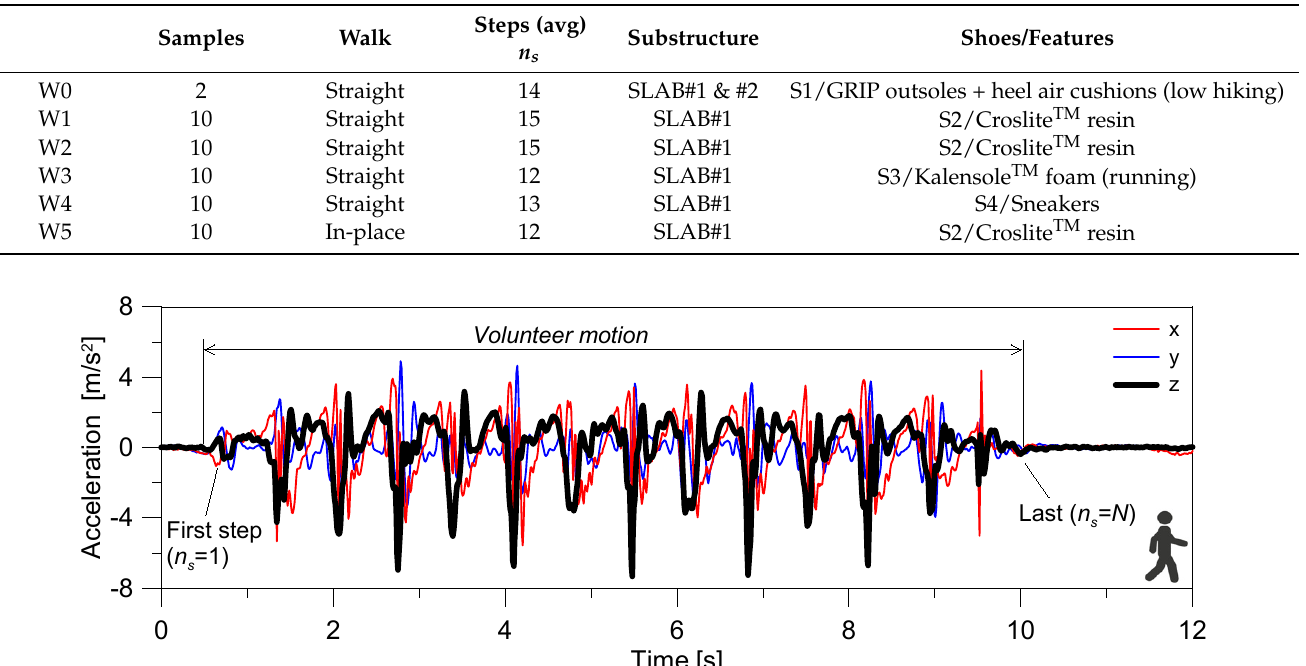
Figure 3. Example of experimental records for body CoM accelerations in time.